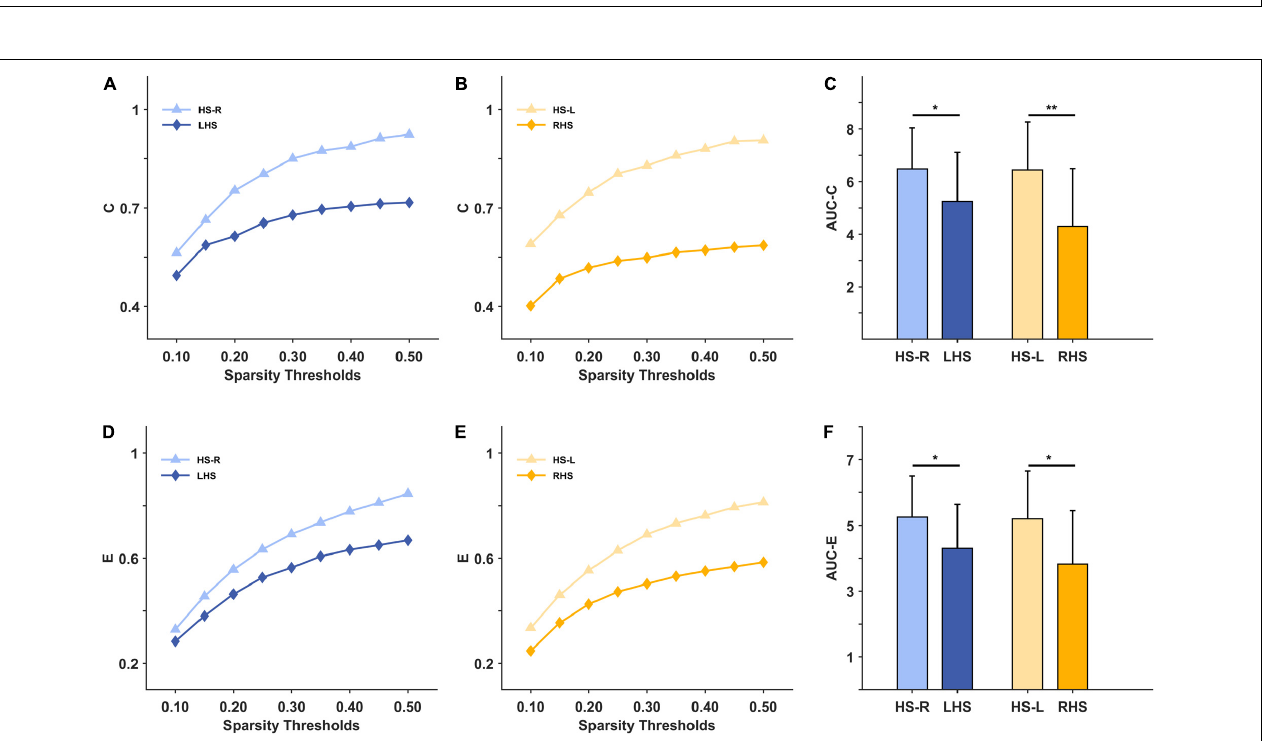
FIGURE 3 | The macroscale brain network indicators under 10–50% sparsity and their area under curves (AUCs) for patients and healthy subjects (HS). (A) the average weighted clustering coefficient under 10%-50% sparsity for HS group (right hand task) and LHS group; (B) the average weighted clustering coefficient under 10%-50% sparsity for HS group (left hand task) and RHS group; (C) the AUCs over the whole sparsity range for the average weighted clustering coefficient in the HS, LHS and RHS groups. (D–F) are for the indicator global efficiency. * p < 0.05, ** p < 0.01.